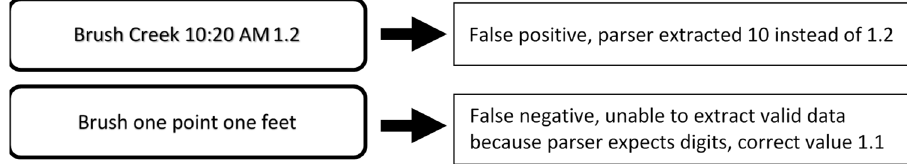
Figure 6. Examples of parser failures (false positive and false negative).